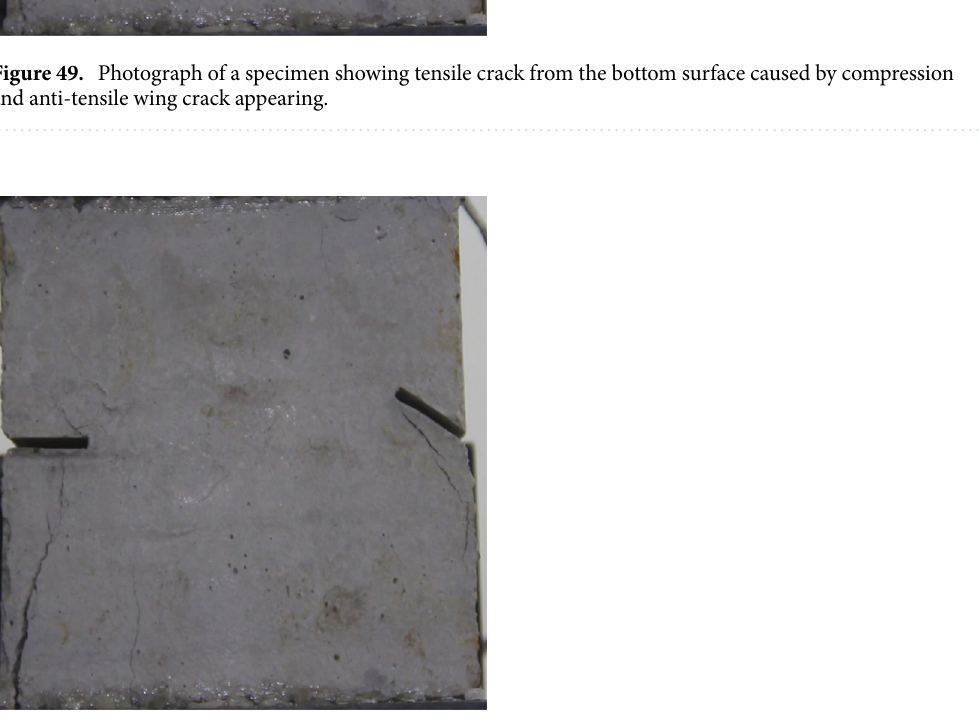
Figure 50. Photograph of a specimen showing tensile crack from the bottom surface caused by compression